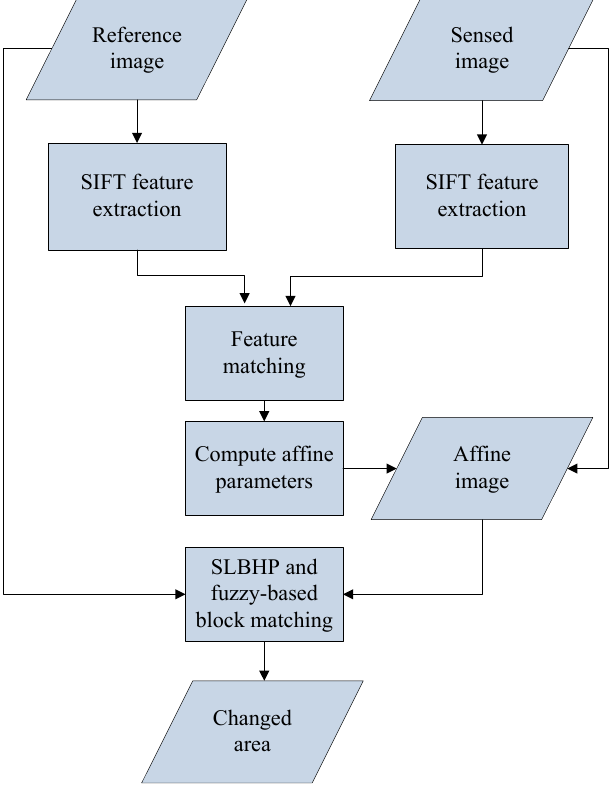
Fig. 6. The proposed SIFT and SLBHP-based block matching change detection algorithm